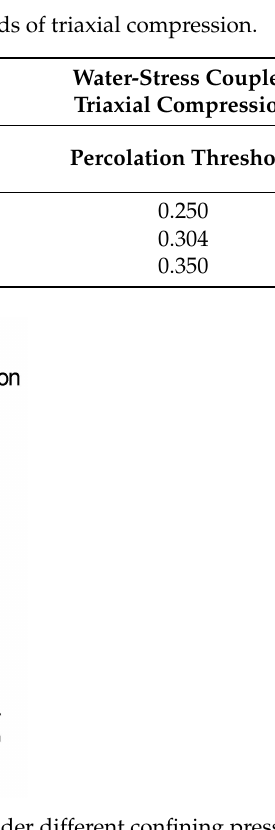
Figure 12. Percolation threshold of triaxial compression test under different confining